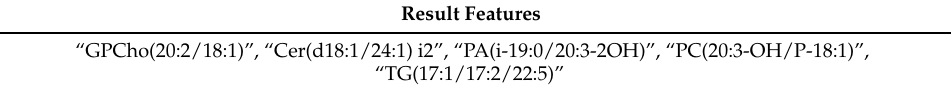
Figure 4. Evolution of maximum fitness scores over generations, using the Control-Prediabetes dataset. The vertical axis represents the fitness score, while the horizontal axis represents a given gen- eration. The solid blue line represents the average fitness across all models. The average unfinished fitness plotted as a solid cyan line represents the average worst case expectation for all failed searches in a given generation. The red dotted line shows the established GA fitness goal. Table 6. Features obtained by the GALGO SVM method in the Control-Prediabetes